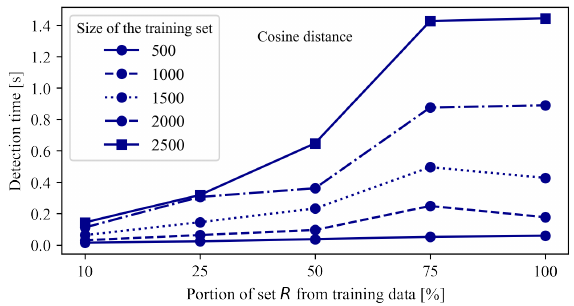
Figure 9. Anomaly detection time of the MLM using cosine distance varying size of the training set and proportion subset R .